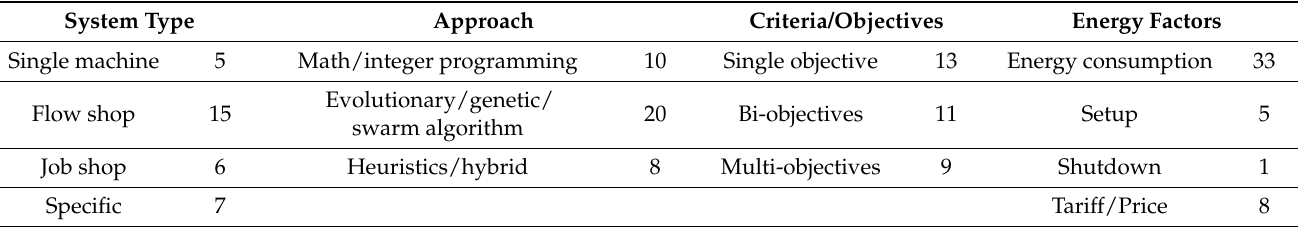
Table 1. Comparative analysis of the selected papers about